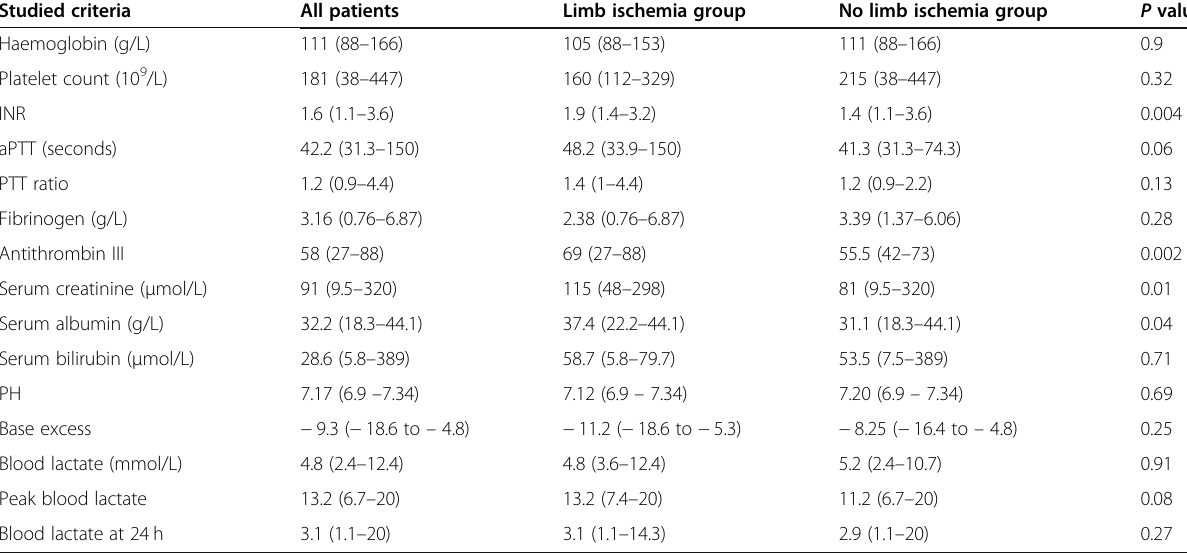
Table 3 Laboratory criteria of the studied VA-ECMO-treated patients Studied